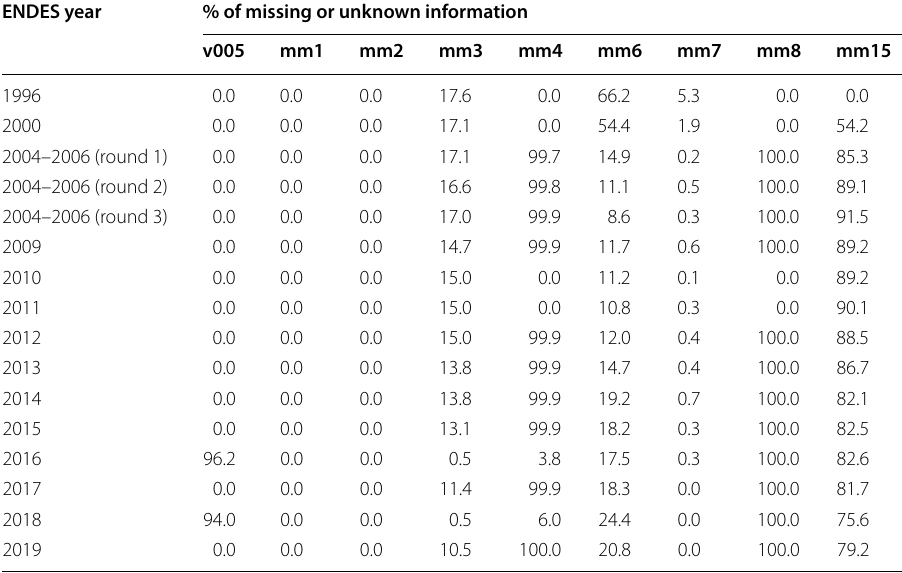
Table 6 Percentage of missing values for age and date variables required for mortality assessment from sibling histories in ENDES